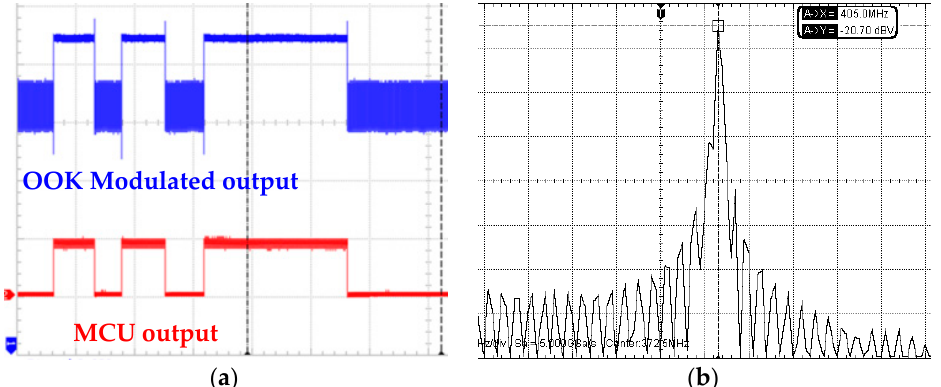
Figure 15. Measurement results of the MICS band transmitter: ( a ) Measured output waveforms of MCU and transmitter; ( b ) Measured transmitter output spectrum.